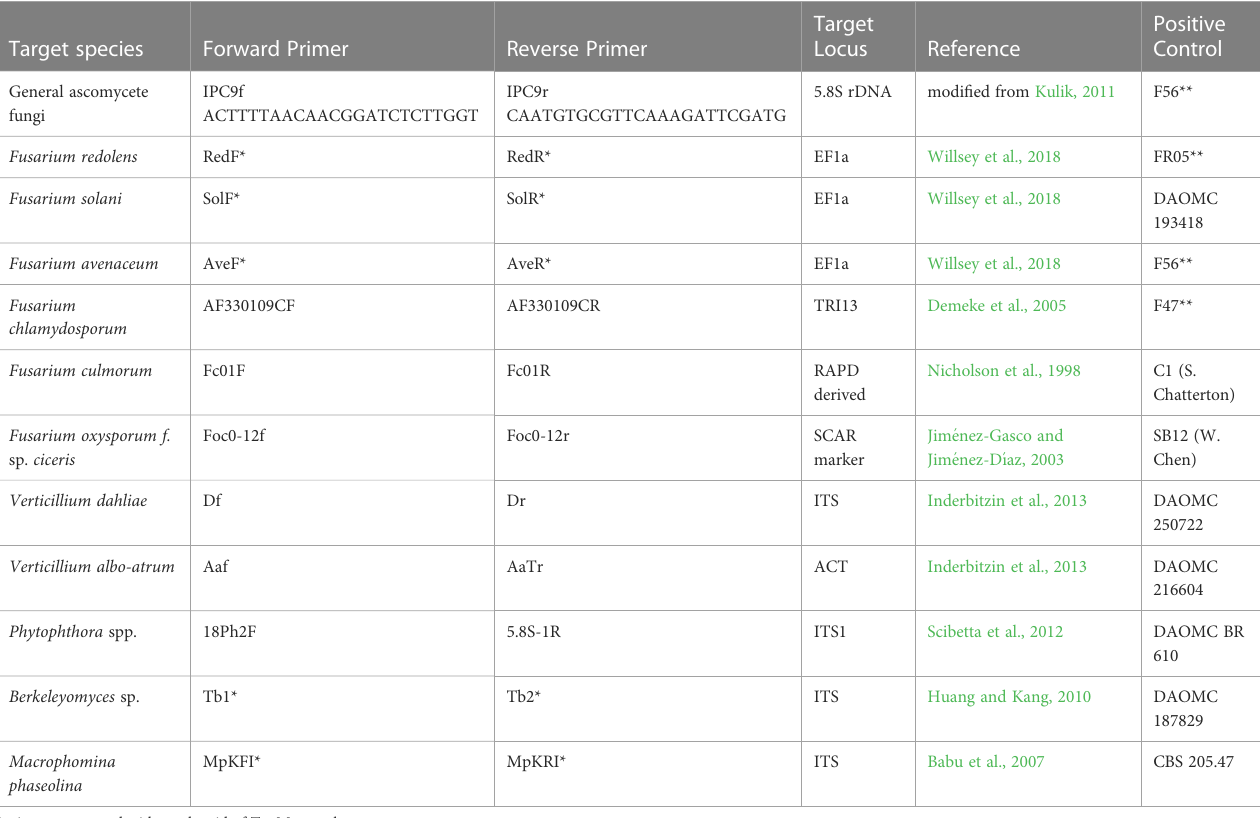
TABLE 1 Primers used for pathogen detection in DNA samples derived from chickpea roots collected in Saskatchewan in 2020 and 2021.